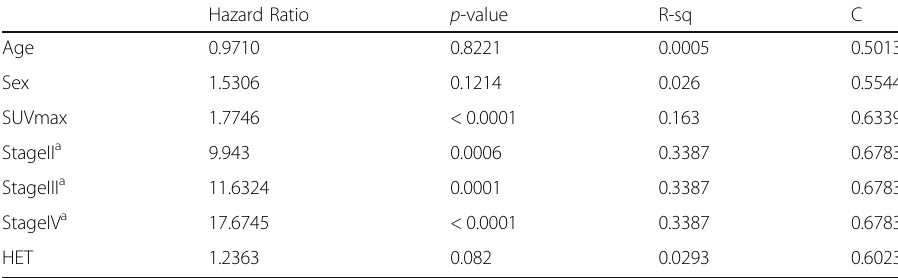
Table 1 Univariate